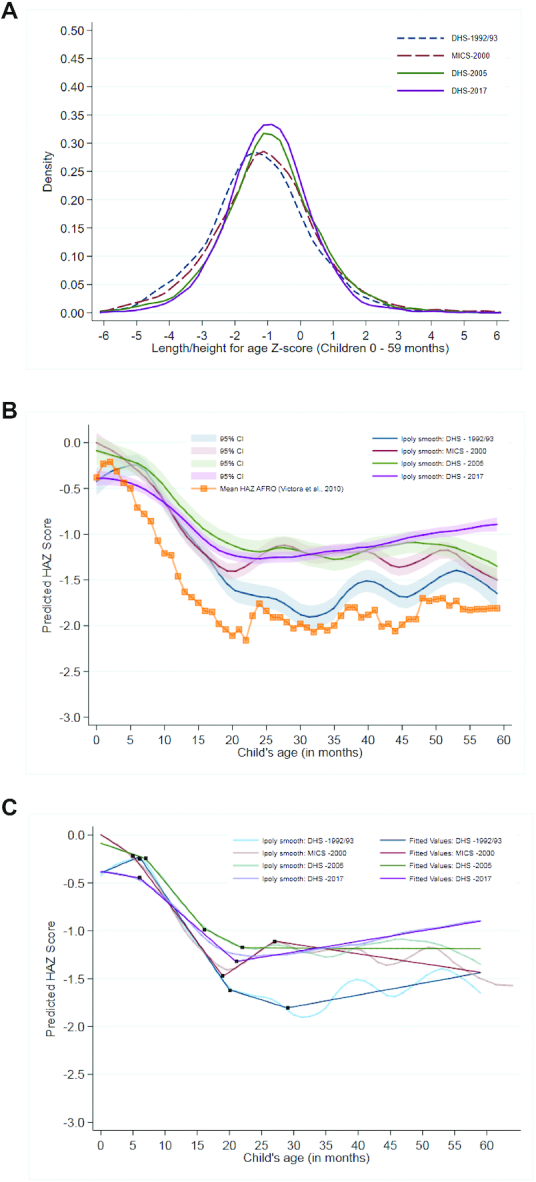
Kernel density plot for HAZ distribution in children < 5 years, 1992/93–2017 (A). Victora curve using data from the 1992/93, 2000, 2005, 2017 surveys among children < 5 years, including AFRO mean HAZ curve (B) (Source: Victora et al., 2010). Victora curve using data from the 1992/93, 2000, 2005, 2017 surveys among children <5 y old with linear splines (C). HAZ, height-for-age z score.